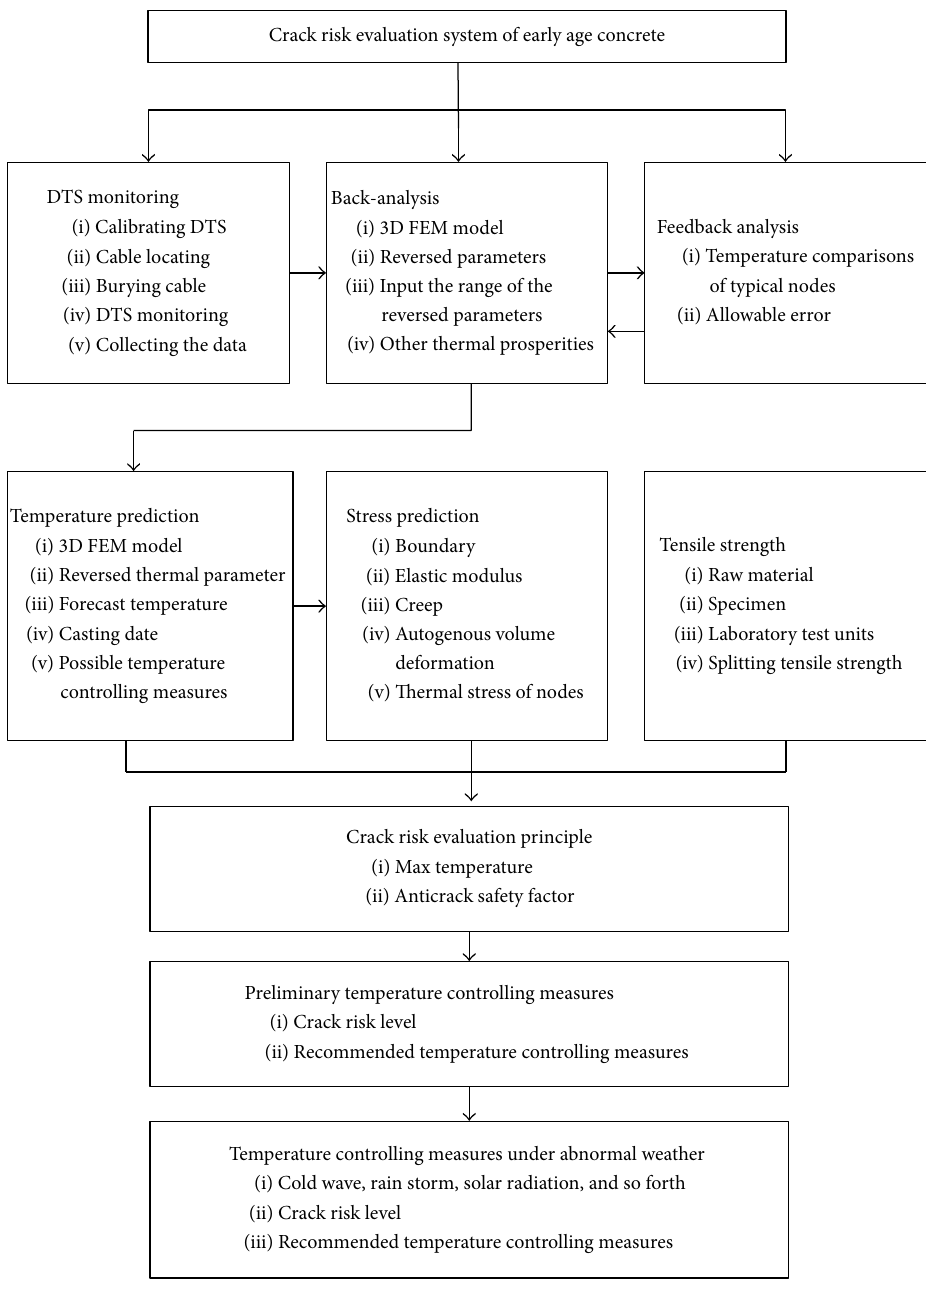
Figure 1: Flow chart of the crack risk evaluation